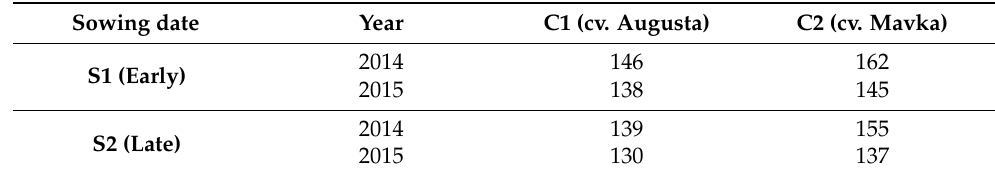
Table 1. Length of growing period (number of days after sowing) depending on sowing date and cultivar.